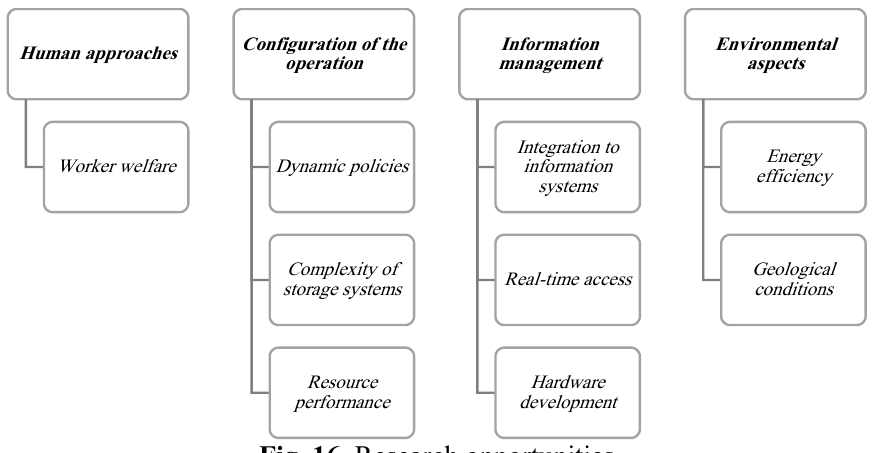
Fig. 16. Research